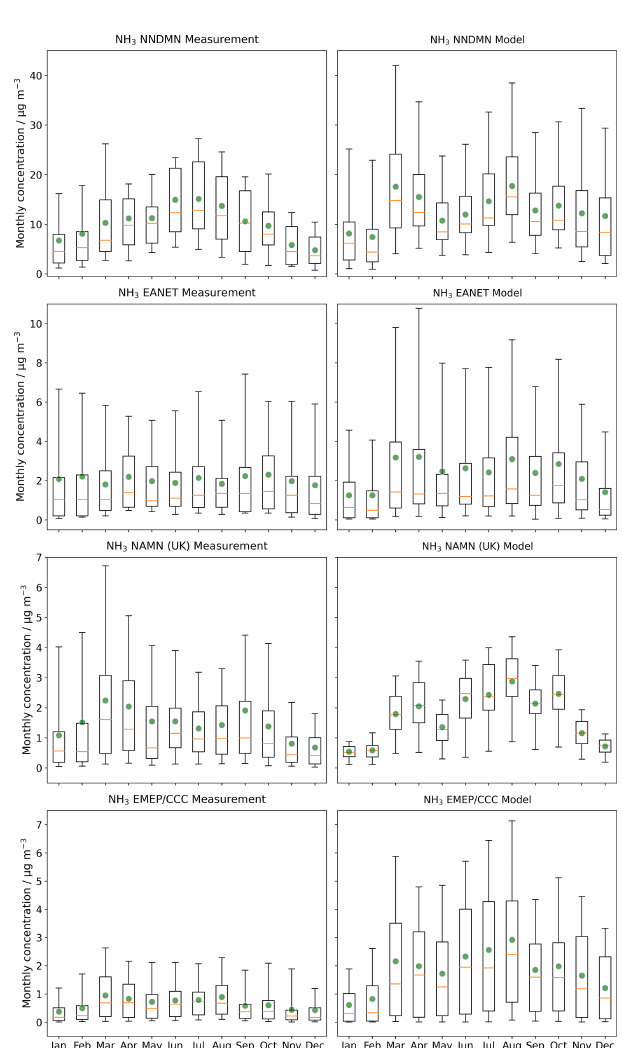
Figure 11. Monthly variations in modelled and measured NH 3 con- centrations for locations in four monitoring networks in 2015. The box extends from the lower to upper quartile values of the data, with an orange line at the median and a green point at the mean. The whiskers represent 5% and 95%